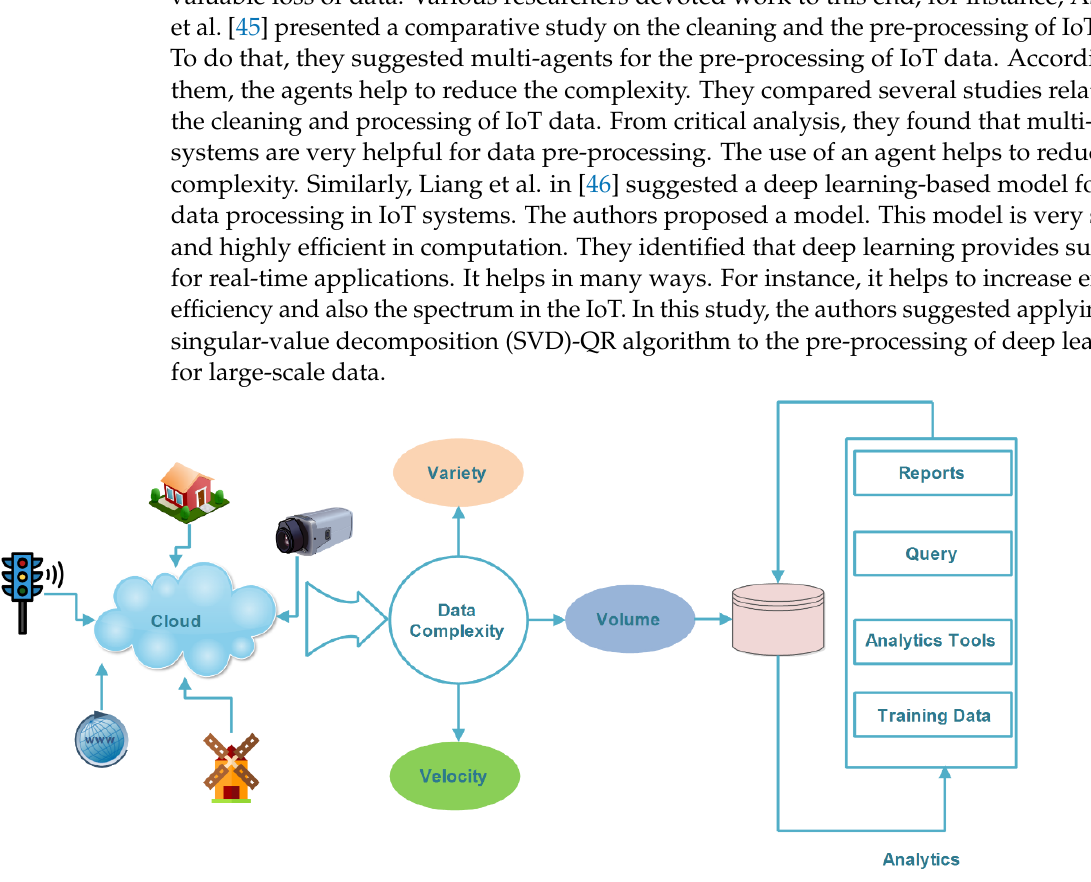
Figure 6. A holistic view of the IoT and big data analytics. Diyan et al. [47] proposed an energy management and processing model for the IoT.